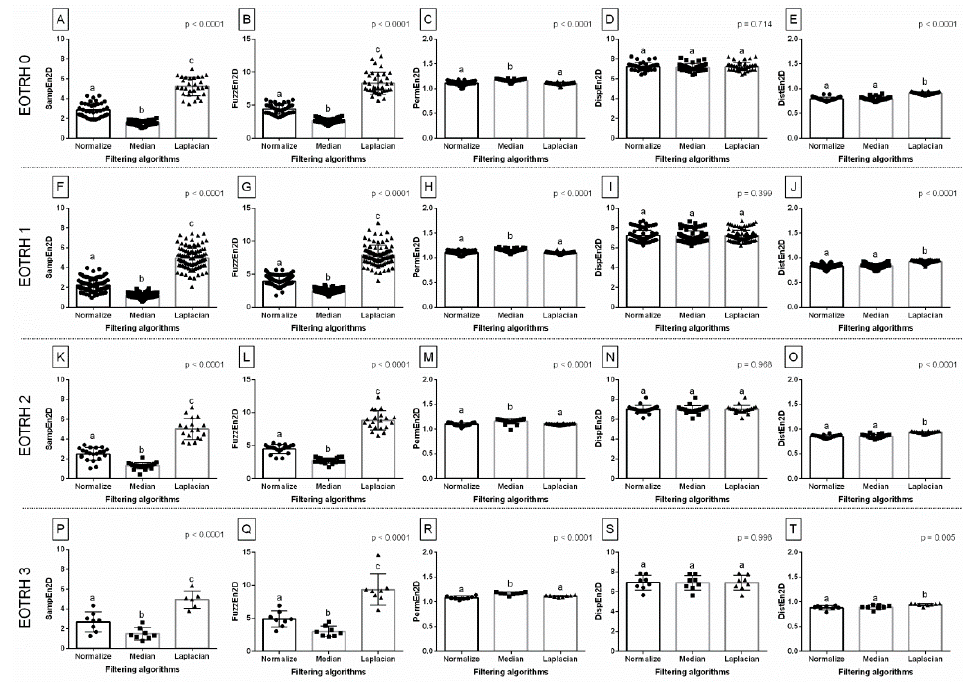
Figure 3. The comparison of the entropy measures between the filtering algorithms. The following entropy measures are considered: SampEn2D—two–dimensional sample entropy ( A , F , K , P ), FuzzEn2D—two–dimensional fuzzy entropy ( B , G , L , Q ), PermEn2D—two–dimensional permutation entropy ( C , H , M , R ), DispEn2D—two–dimensional dispersion entropy ( D , I , N , S ), DistEn2D—two–dimensional distribution entropy ( E , J , O , T ). The radiographs classified to EOTRH 0 grade ( A – E ), EOTRH 1 grade ( F – J ), EOTRH 2 grade ( K – O ), and EOTRH 3 grade ( P – T ) are separated by dashed horizontal lines. Lower case letters (a–c) indicate differences between groups for p < 0.05 independently for each measure. Single realizations are marked with dots.